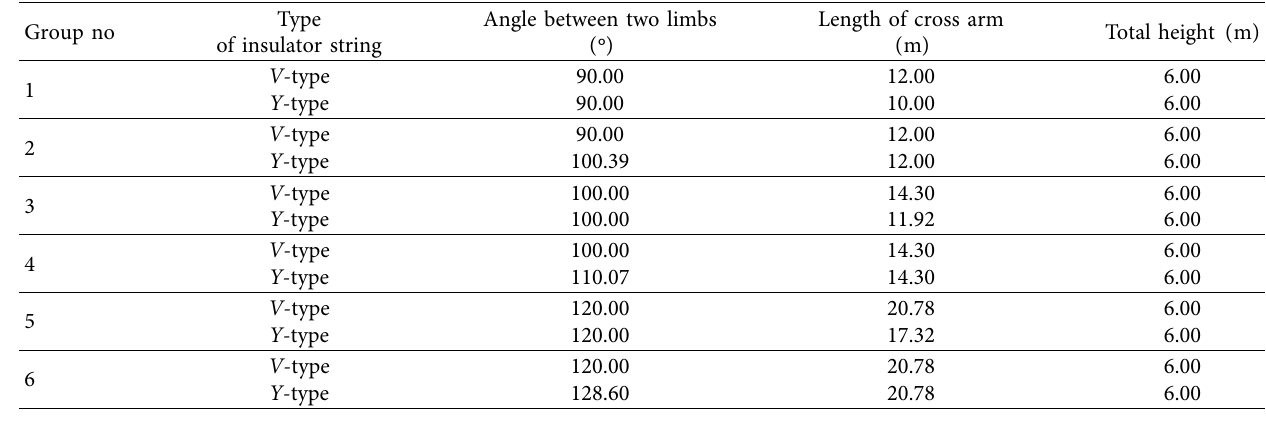
Table 5: Te conductor parameters of JL/GIA-630/45.